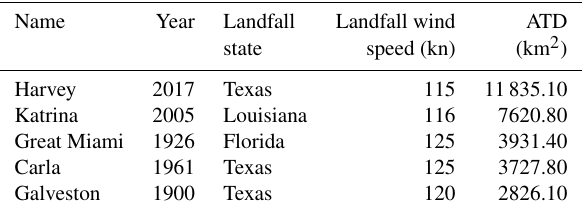
Table 2. Summary of the most destructive hurricanes that made landfall in the United States between 1900 and 2017 as defined by their respective